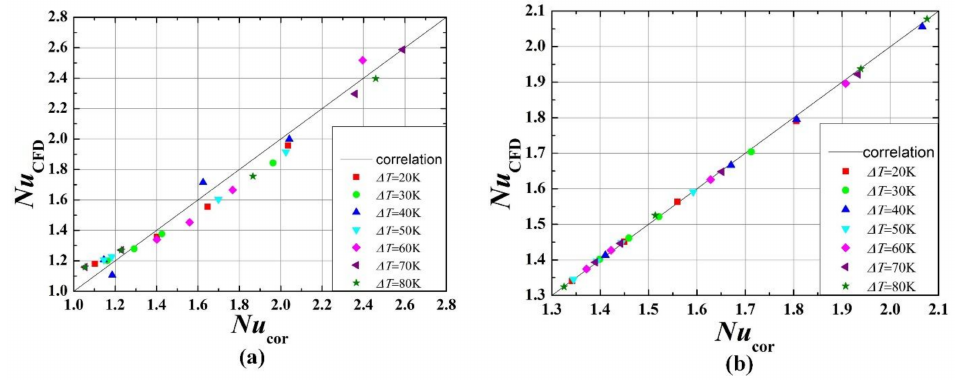
Figure 13. Comparison between calculated results by correlation equations and CFD results for average Nusselt number: ( a ) horizontal enclosure; ( b ) vertical